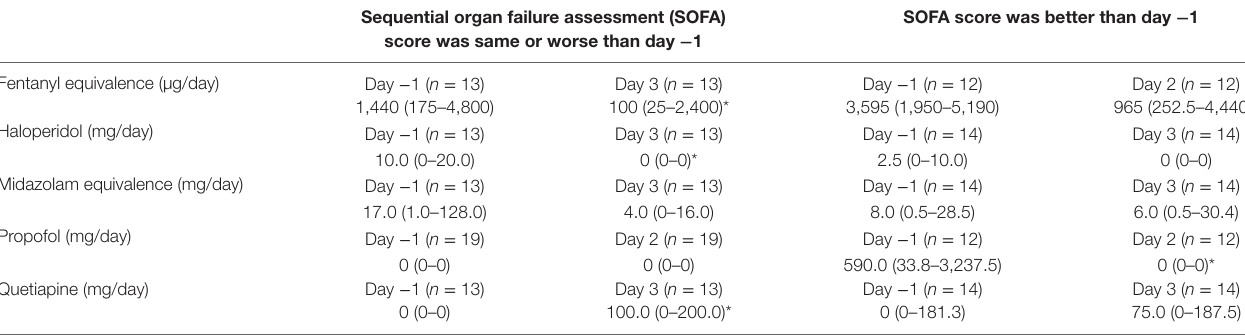
TablE 3 | Changes in medication dosing among patients who improved or deteriorated clinically. Sequential organ failure assessment (SOFa) score was same or worse than day − 1